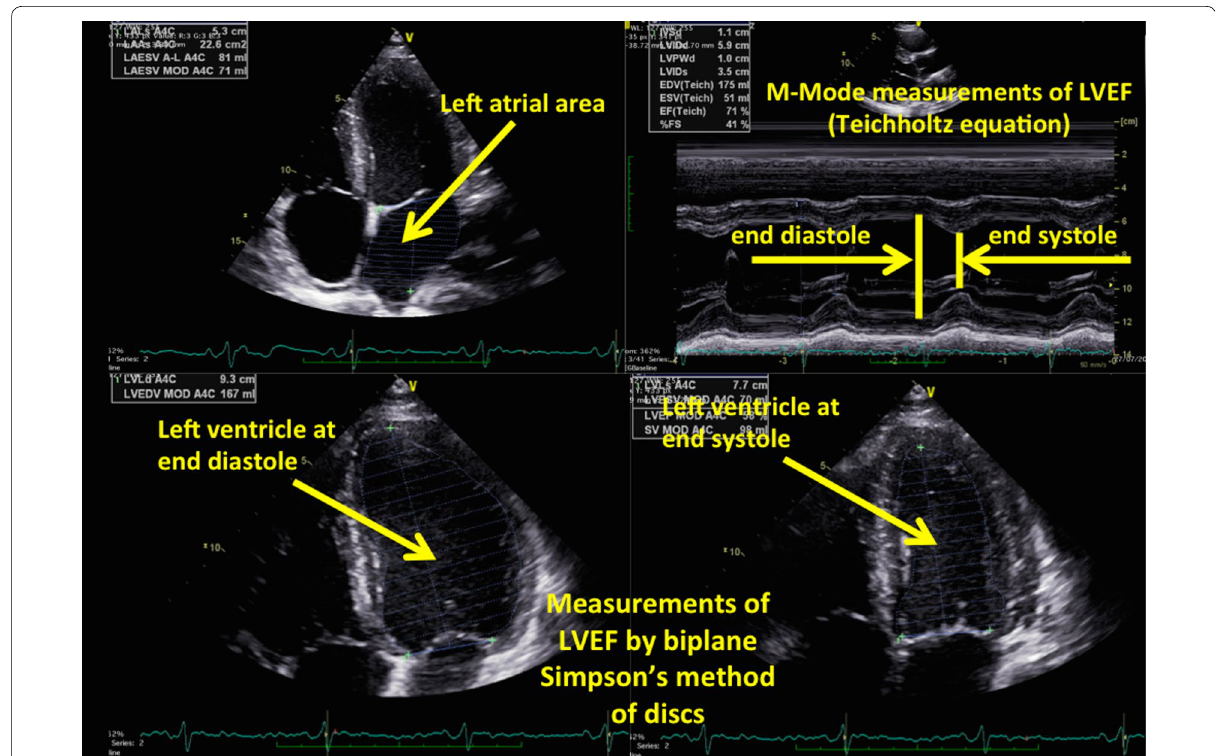
Fig. 2 Echocardiographic assessment of left ventricular systolic function (Simpson’s method and Techoltz equation) as defined by Lang et al.